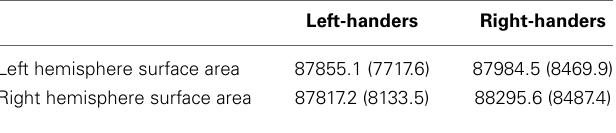
Table 1 | Mean surface areas (and SD s) for the left and right hemispheres, by handedness.